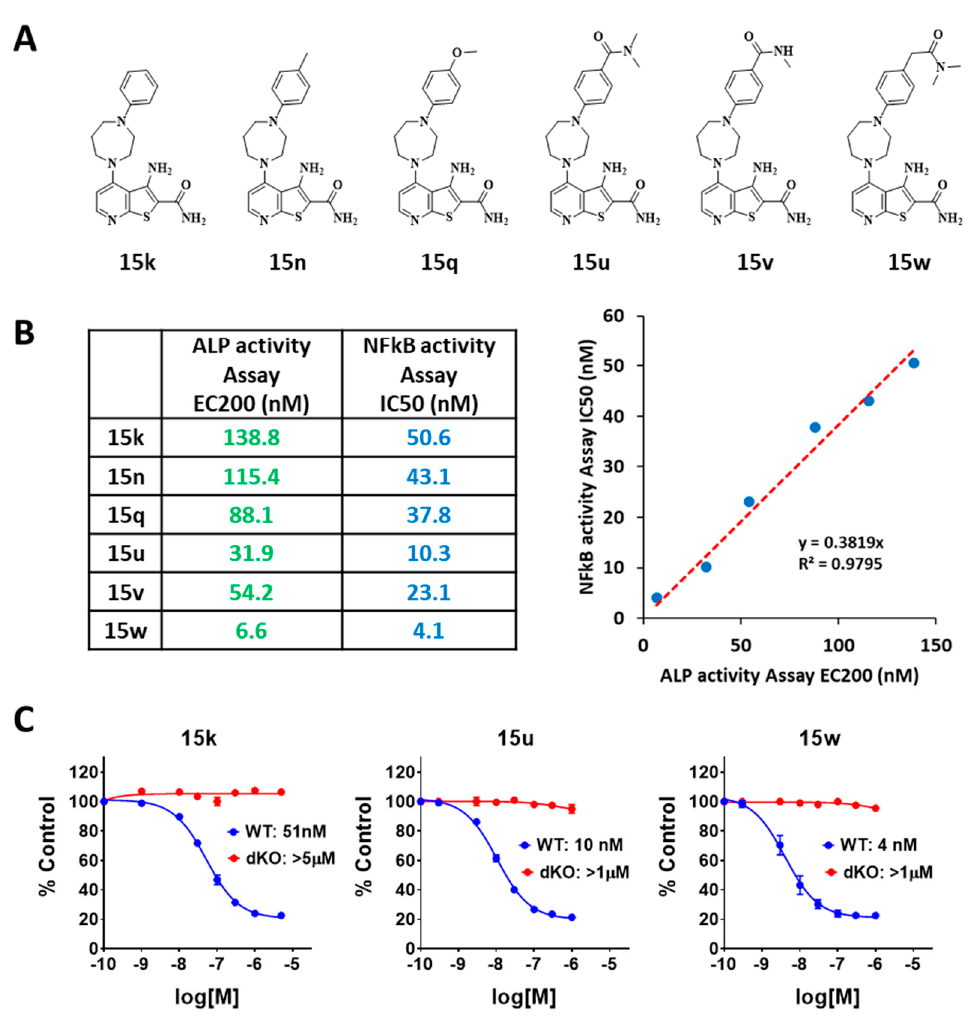
Figure 4. ( A ) Chemical structures of thienopyridine derivatives 15k, 15n, 15q, 15u, 15v and 15w. ( B ) Comparisons of IC 50 values of the indicated thienopyridines measured in the NF κ B reporter assay in WT 293 cells with the reported EC200 values in the ALPase activity assay in ST2 cells. ( C ) Effects of 15k, 15u and 15w at different concentrations on the induced NF κ B reporter activity in WT and dKO 293 cells treated with 10 ng/mL TNF α for 3 h.